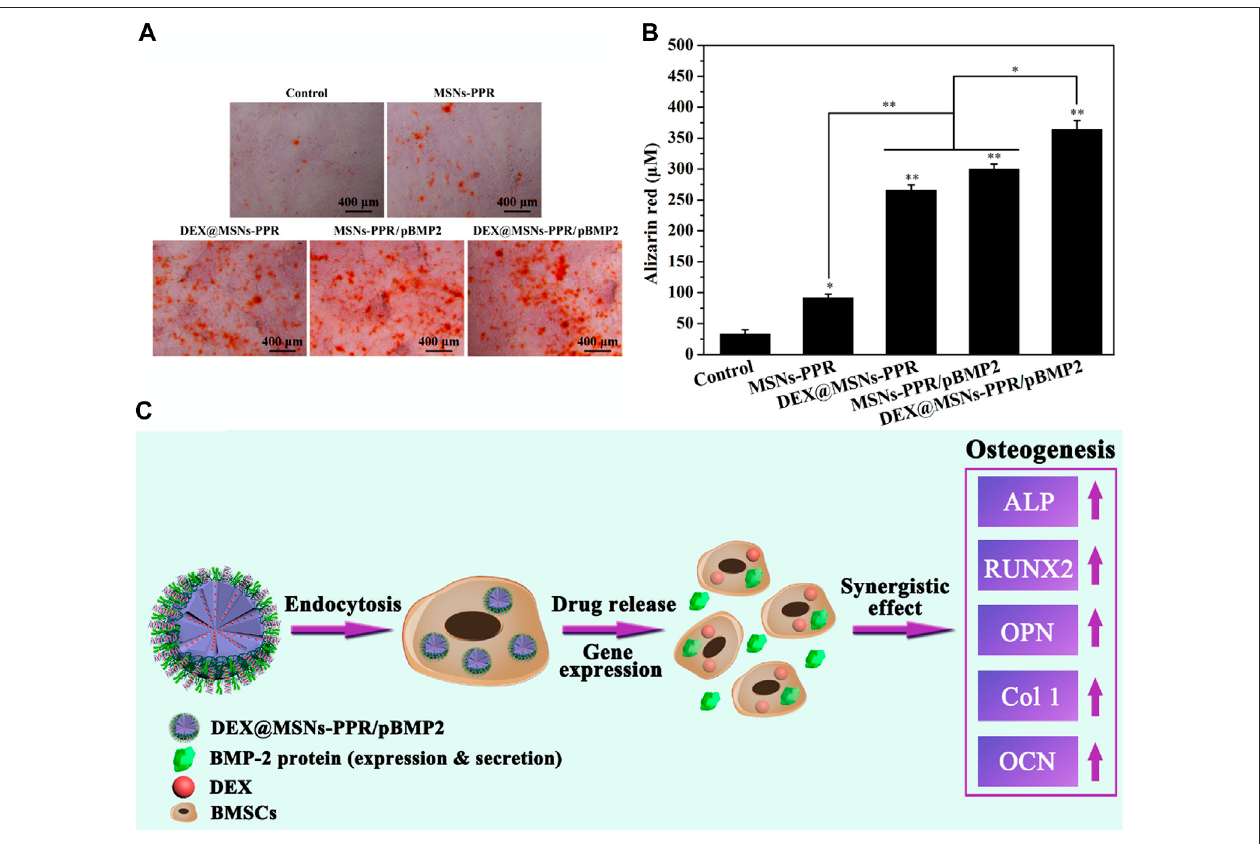
FIGURE7| EvaluationofthemineralizationinBMSCsafterincubationwithdifferentsamplesfor21 days (A) DigitalphotosofalizarinredSstaining. (B) Quantitative analysis of mineralized matrix. (C) Schematic illustration of the osteogenic differentiation of BMSCs induced by the MSNs-based BMP-2 gene and DEX codelivery system. * p < 0.05 and ** p < 0.01 against the control group. Reprinted with permission from Zhou et al. (2019). Copyright © 2019 American Chemical